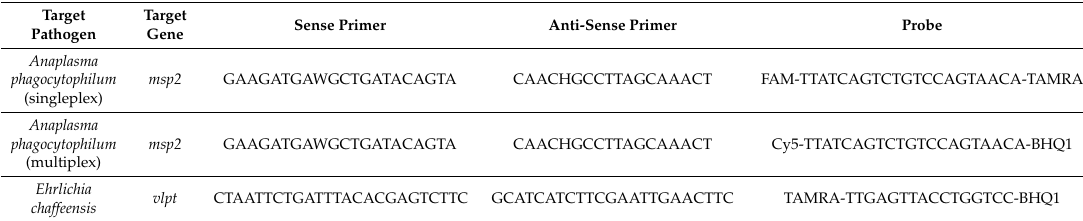
Table 1. Primers and probes used for singleplex and multiplex PCR for A. phagocytophilum and E. chaffeensis